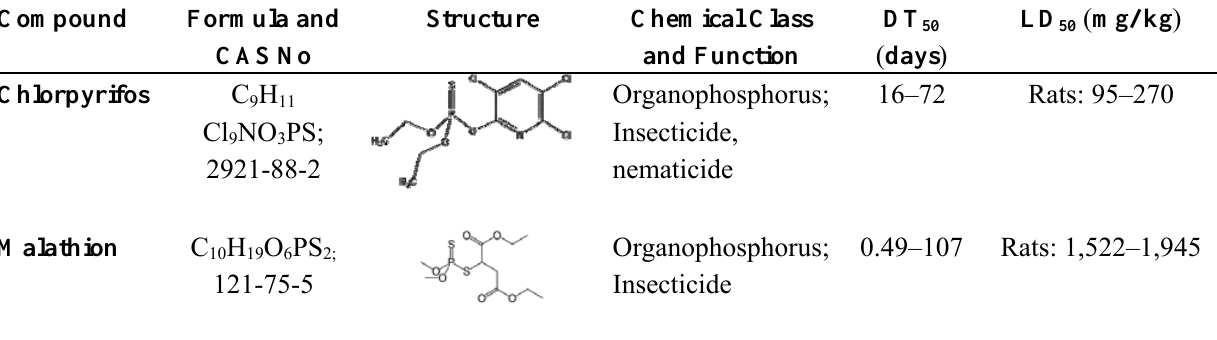
Table 1. Structures, chemical properties, functions, DT investigated in this